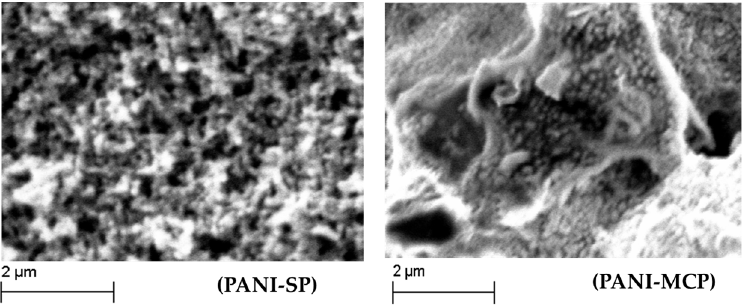
Figure 5. SEM micrographs (20,000 X) of PANI powder, produced in solution (PANI ‐ SP) or by mechanochemical polymerization (PANI ‐ MCP). The experimental details are described in the supplementary information.